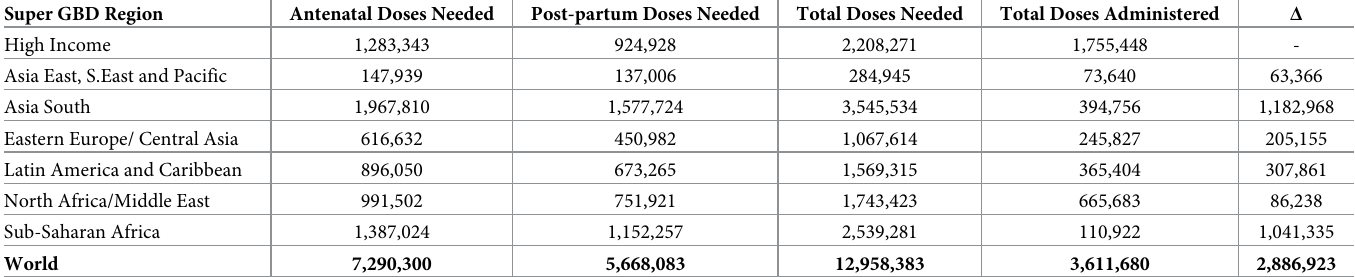
Table 1. The number of anti-Rh(D) doses required annually to prevent maternal sensitization to Rh(D), and the number of anti-Rh(D) doses actually administered annually. Super GBD Region